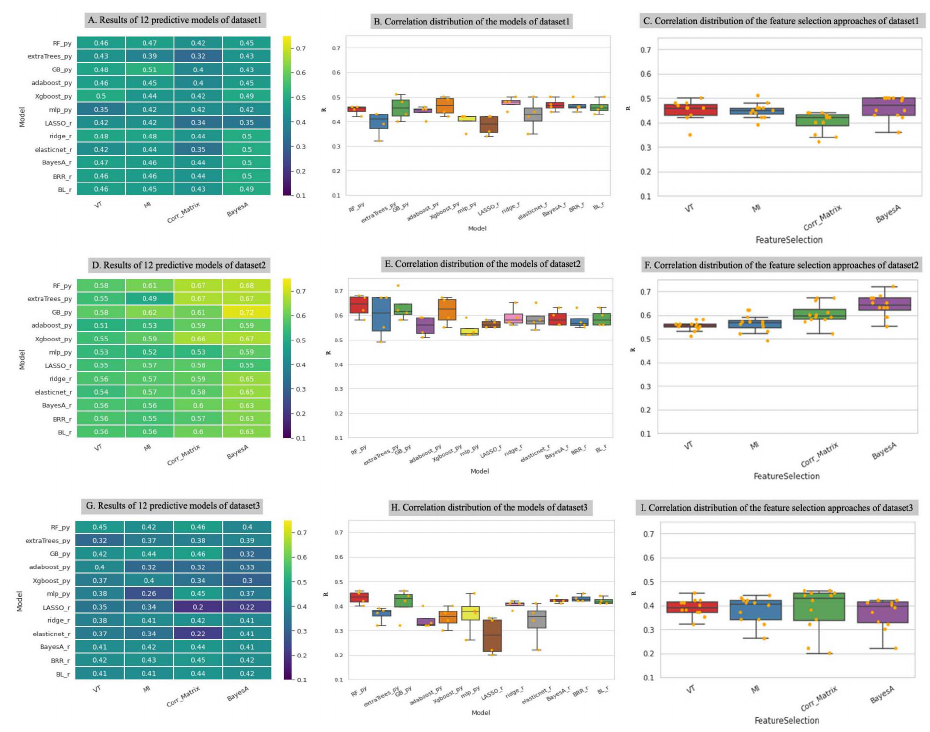
Figure 2. The performance of the predictive models on dataset1, dataset2, and dataset3 across the feature selection methods. ( A , D , G ) Heat map of obtained coefficient of determination ( R ) on highly predictive SNPs, selected using variance threshold (VT), correlation matrix (Corr_Matrix), mutual information (MI), and BayesA. ( B , E , H ) Box plot of obtained R scores, organized by prediction model. ( C , F , I ) Box plot of obtained R scores, organized by feature selection method.